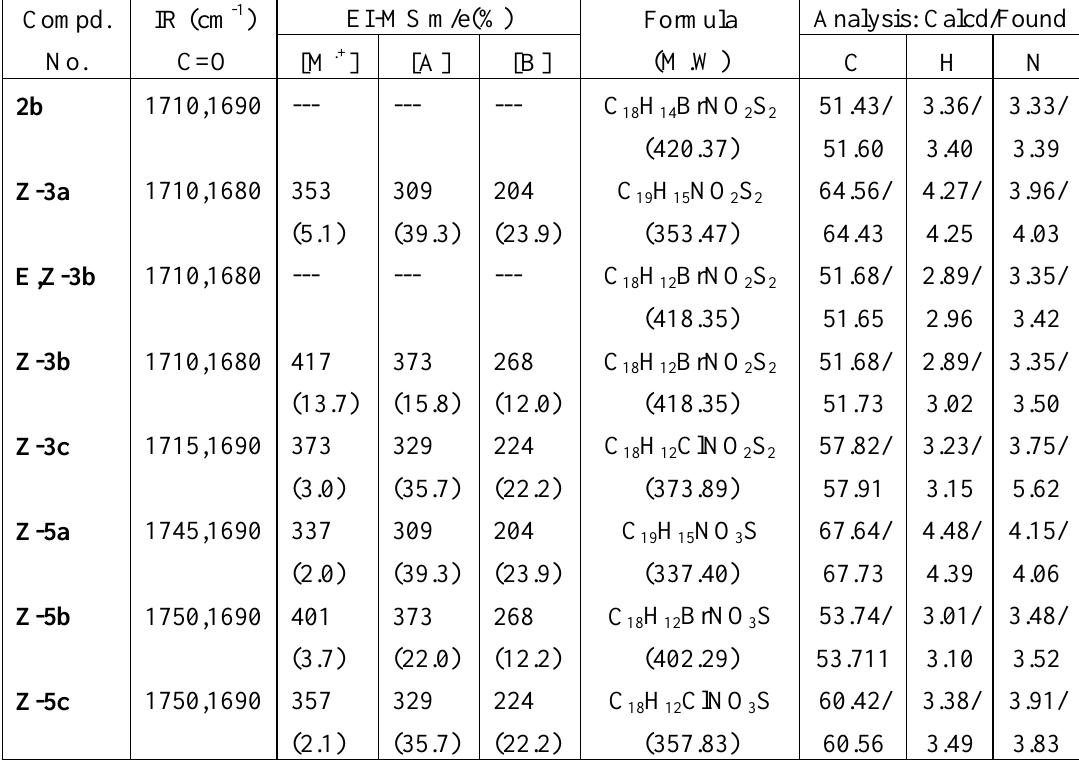
Table 3: Spectral and Analytical Data of Newly Synthesised compounds EI-MS m/e(%) Analysis: